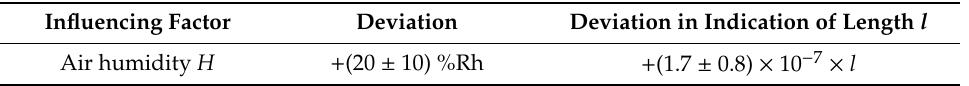
Table 9. Example of a calibration result of an air pressure sensor and the e ff ect on a measured length. Influencing Factor